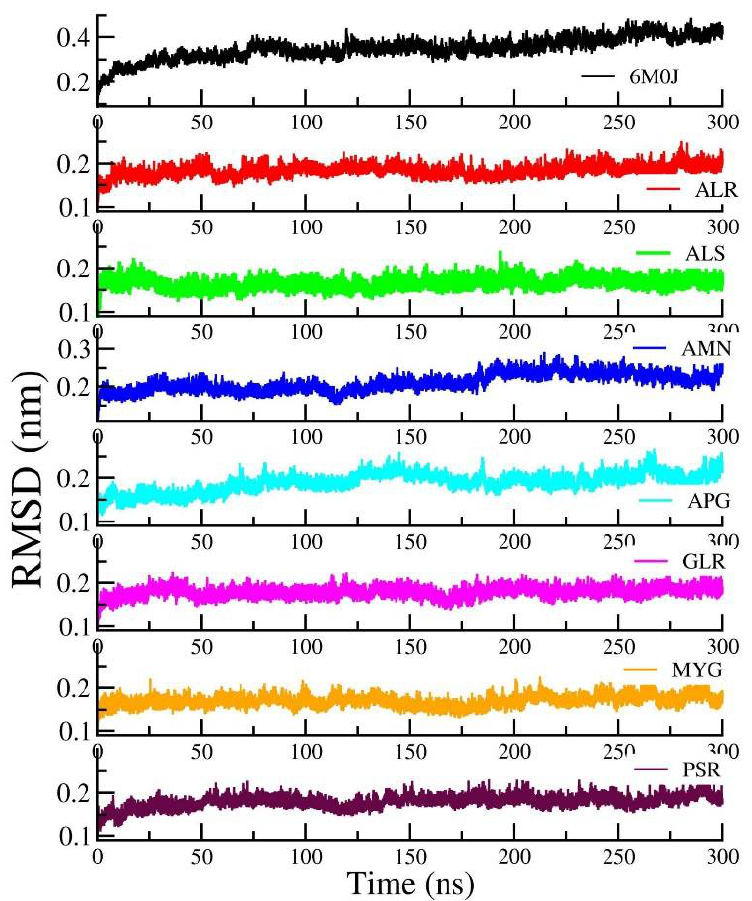
Figure 5. Time dependence of the root mean square deviation (RMSD) of the protein from the production run of all seven protein–ligand complexes and compared with protein in water simulation.